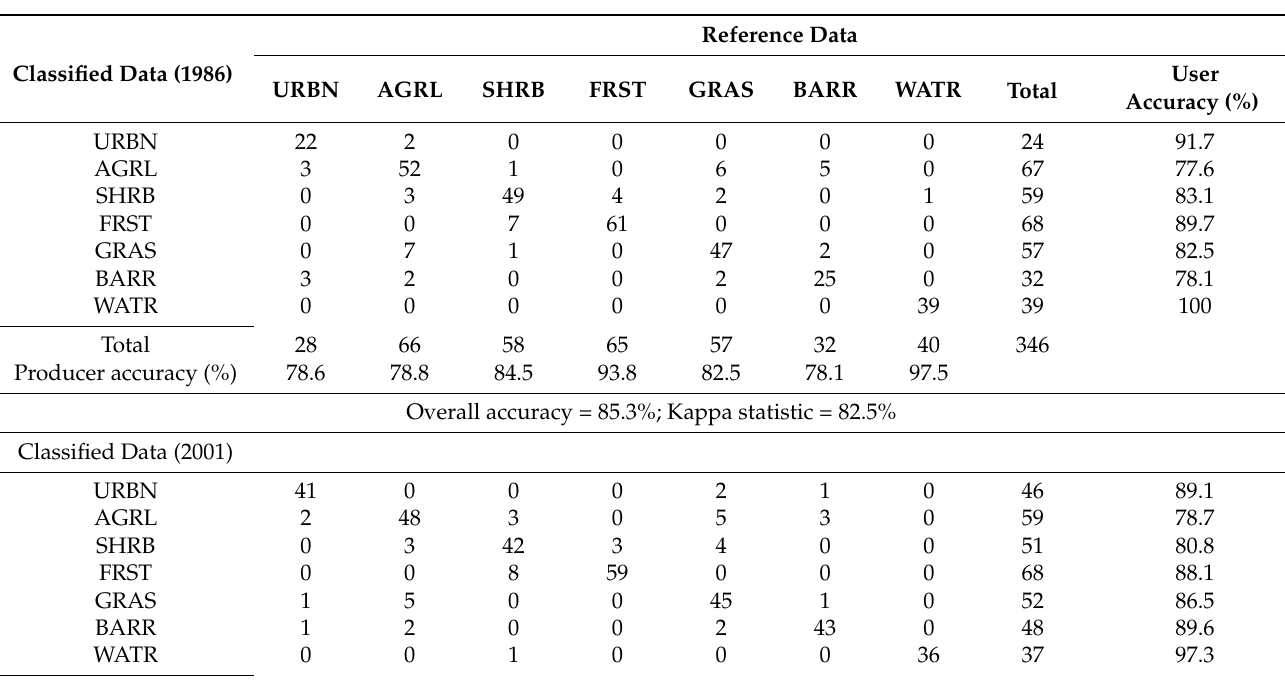
Table 7. Accuracy assessment of the 1986, 2001, and 2016 classified